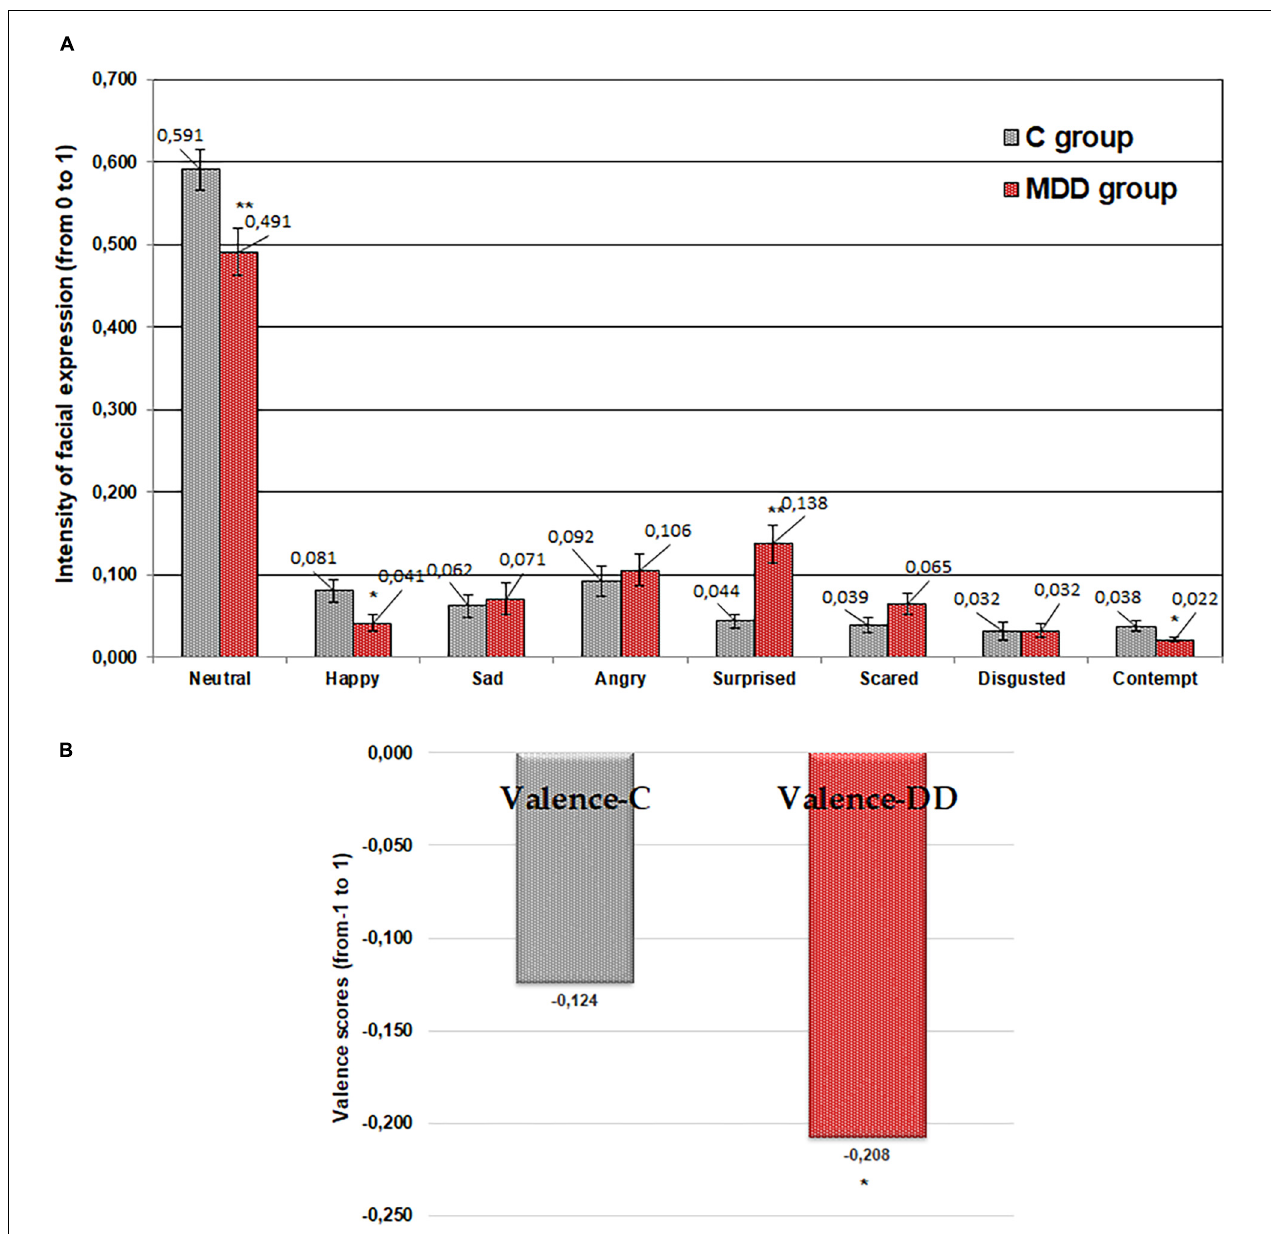
FIGURE 3 | Emotions (“neutral,” “happy,” “sad,” “angry,” “surprised,” “scared,” “disgusted,” and “contempt”) induced by imagined “salty” tasting food (A) and valence (B) for patients with major depressive disorder (MDD group) and without MDD (C group). Significant difference between groups: *p ≤ 0.05; **p ≤ 0.01.